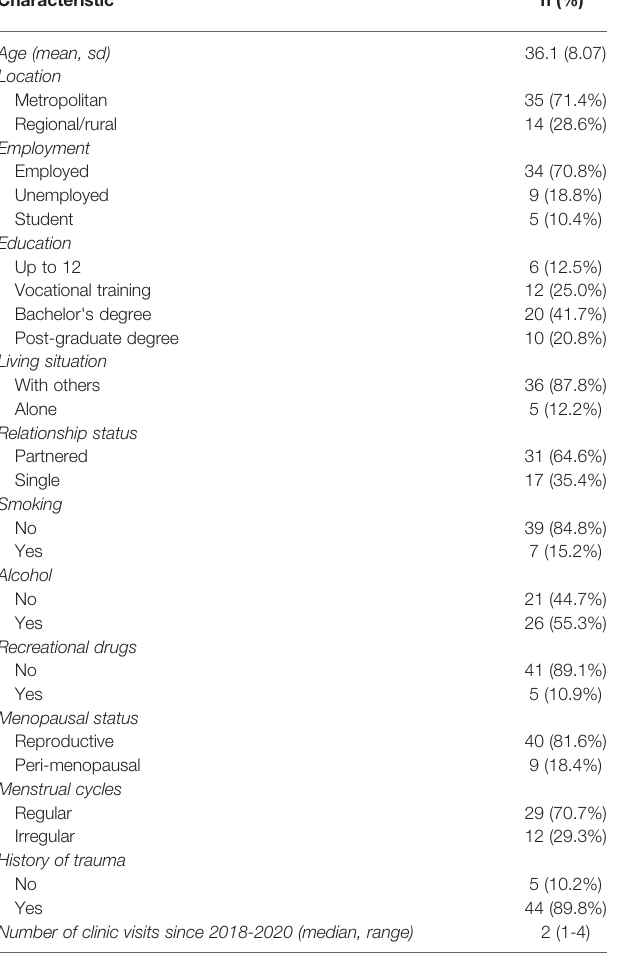
TABLE 1 | Participant characteristics.